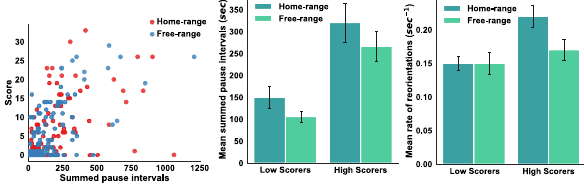
Figure 7. Left: Summed pause intervals plotted against score and separated by home-range versus free-range foraging. Center: Means of summed pause intervals, and Right: mean rates of reorientations. Error bars show standard error of the